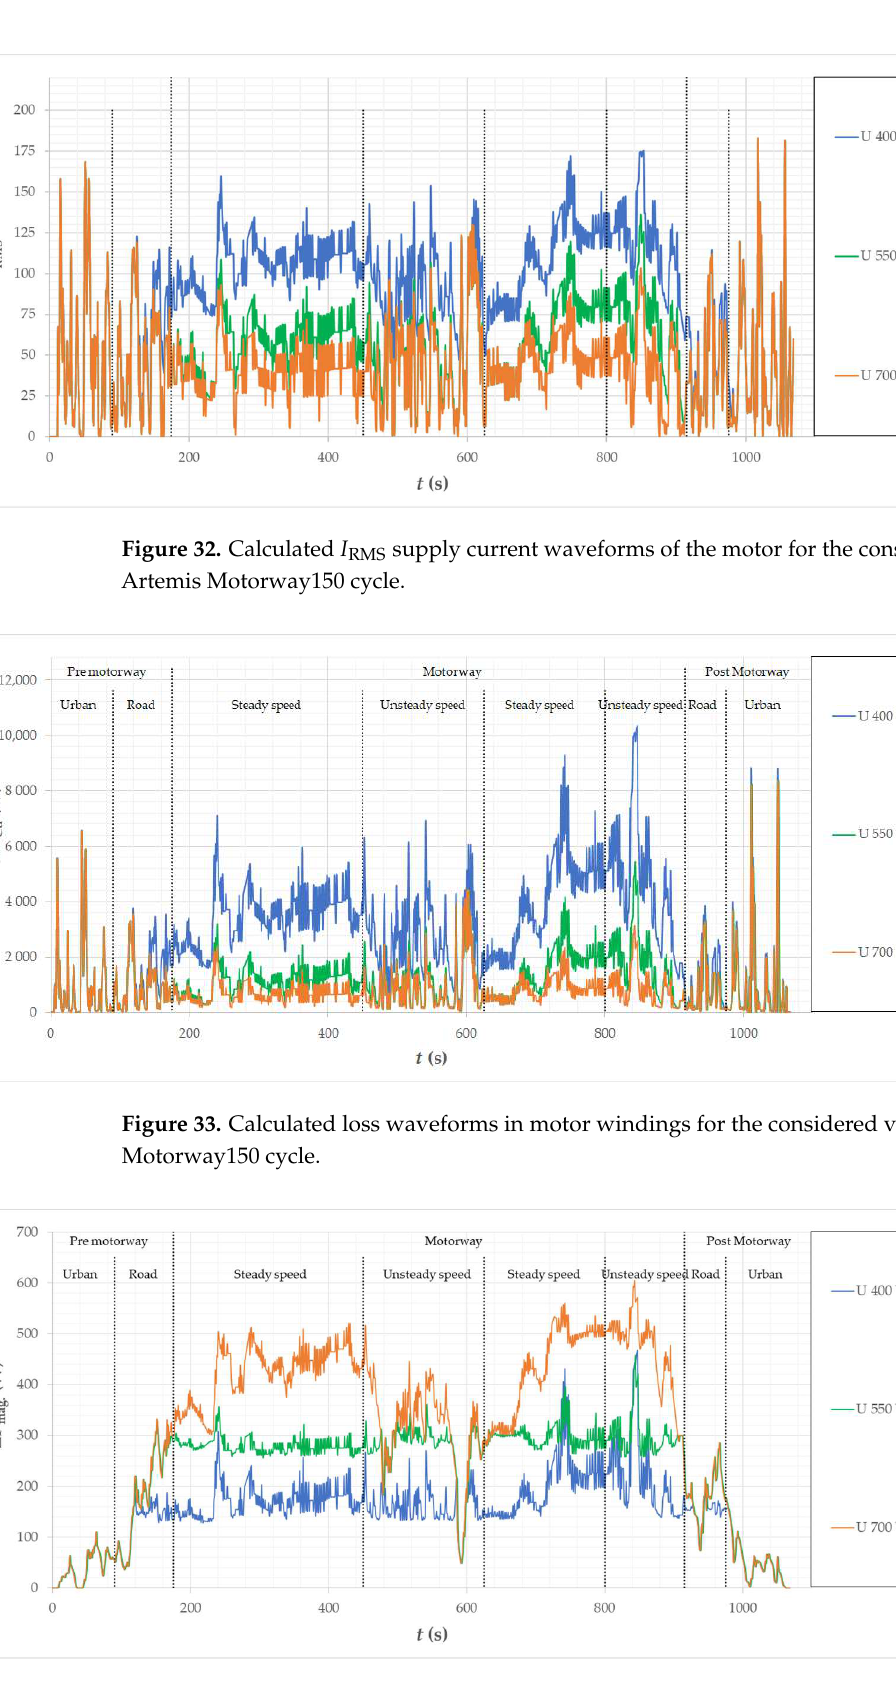
Figure 31. Calculated vehicle torque waveform of the Artemis Motorway150 cycle .